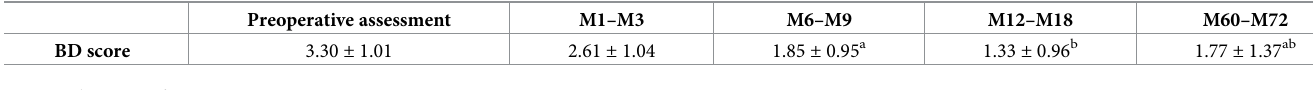
Table 3. The BD score (mean ± SEM) during follow-up. Means with different superscripts are significantly different from each other ( P < 0.05). Preoperative